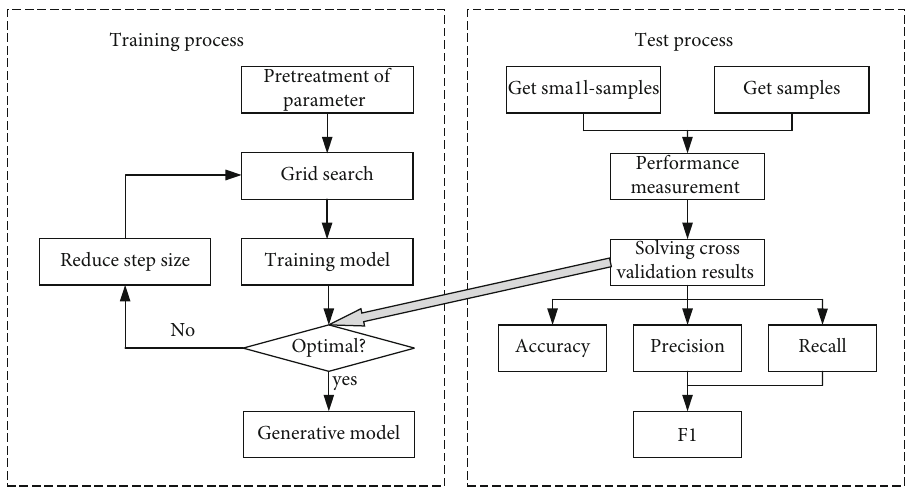
Figure 3: Flow chart of training and testing. There are four steps to generate the SVM model. Inside the left box is the training process, corresponding to steps 1 – 3 below. Inside the right box is the test process, corresponding to Step4